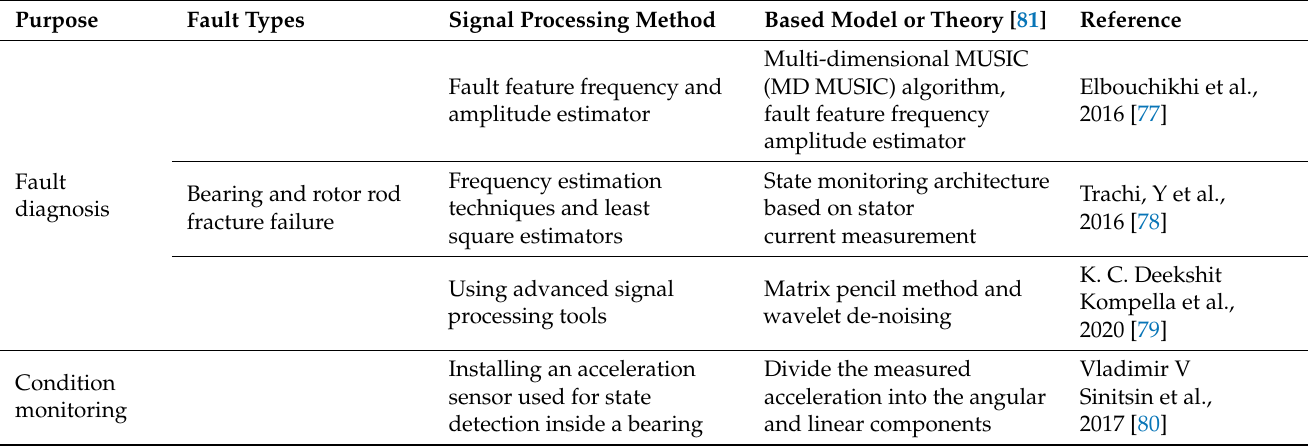
Table 6. Summary and comparison table of spectral signal analysis methods.